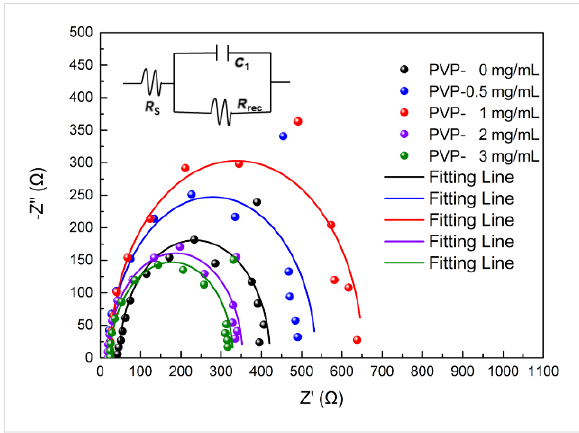
Figure 5: Nyquist plot of the PSCs measured within the frequency range from 100 Hz to 1 MHz under AM 1.5G irradiation at a direct cur- rent bias of 0 V. Symbols are experimental data and solid lines corre- spond to the fits using the equivalent circuit (inset).